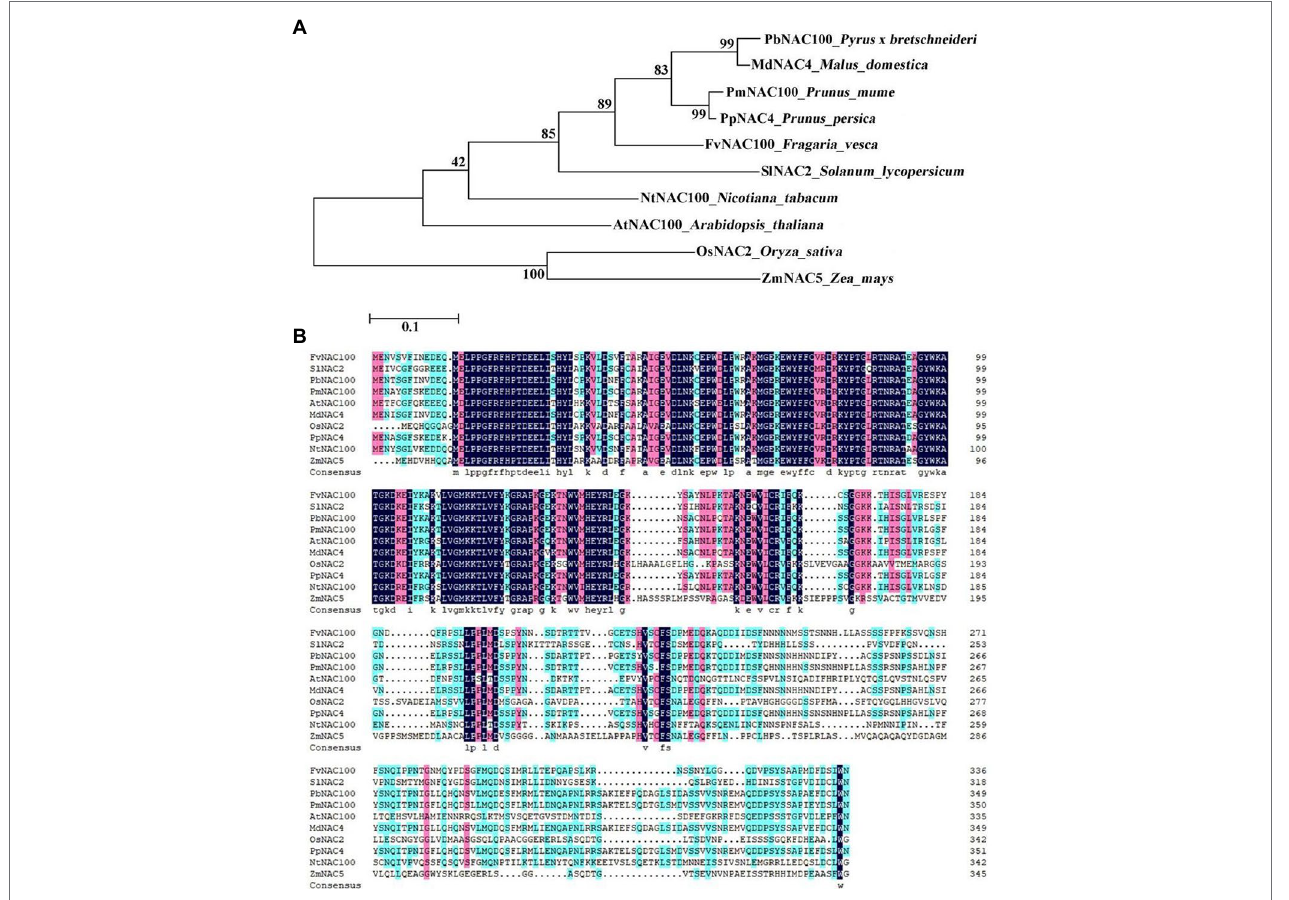
FIGURE 1 | Phylogenetic tree analysis and amino acid sequence alignment of NAC4 proteins in different species. (A) Phylogenetic tree analysis of NAC4 proteins in different species; (B) Multiple alignments of NAC4 amino acid sequences in different species. (AtNAC100: NP_200951.1; NtNAC100: XP_016439814.1; OsNAC2: XP_015633922.1; ZmNAC5: PWZ29660.1; SlNAC2: NP_001316319.1; FvNAC100: XP_004304286.1; PpNAC100:ALK27823.1; PmNAC100: XP_008230794.1; PbNAC100: NP_001289216.1; MdNAC4: